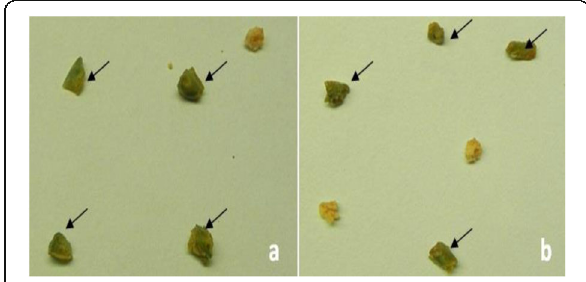
Fig. 4 Assay of GUS activity in transformed calli of Citrus reticulata Blanco ( a ) and Citrus sinensis (L.) Osbeck ( b ). Arrow indicates the GUS-positive calli (blue